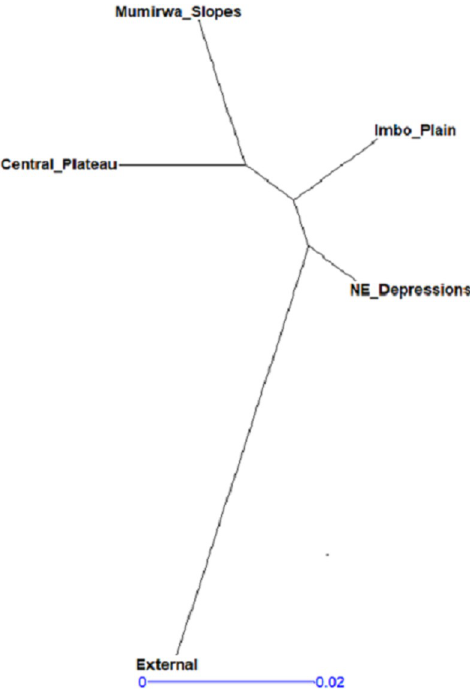
Fig 7. Genetic relationships between cassava populations based on Nei’s genetic